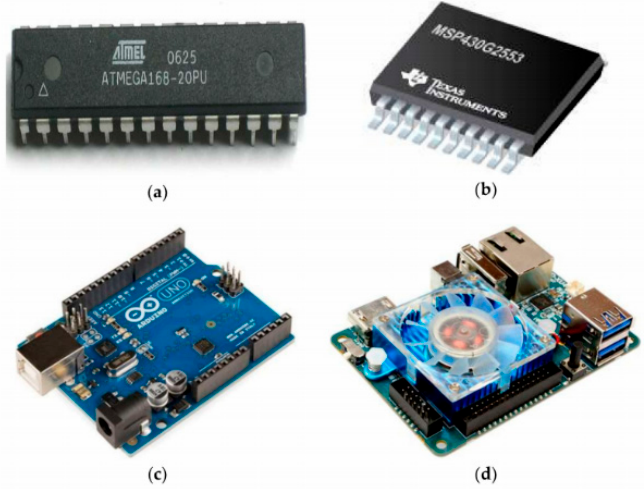
Figure 11. ( a ) ATmega microcontroller, ( b ) MSP430G2553 microcontroller, ( c ) Arduino Uno board, and ( d ) Android XU4 minicomputer